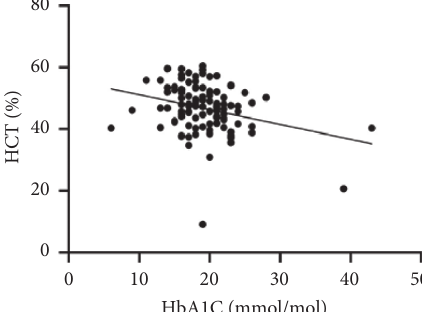
Figure 5: Relation between hematocrit and HbA1c ( r � 0.083; p � 0 . 0017).